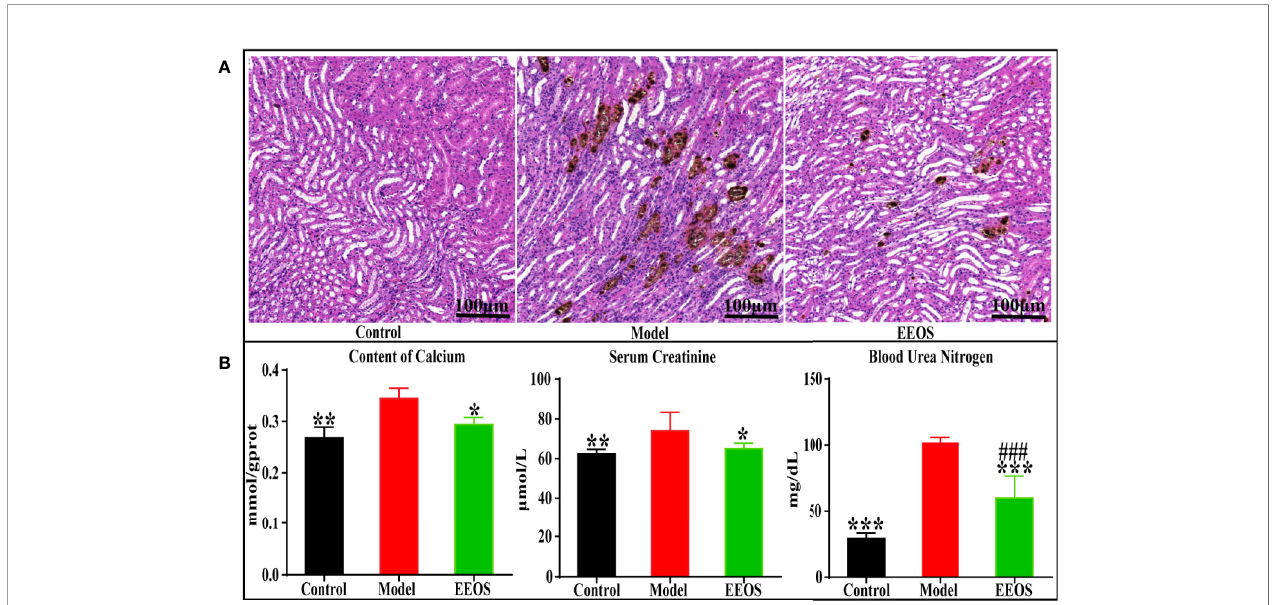
FIGURE 1 | Tissue sections (×400) and biochemical indicator analysis. (A) Kidney slice stained with Von Kossa of the control group, model group and EtOAc extract of OS (EEOS) group. A large number of calcium spots were observed in the model group kidney sections and calcium spots in kidney stones mice are signi fi cantly reduced after taking EEOS; (B) the levels of Calcium, Serum creatinine and Blood urea nitrogen in the kidneys of three groups of mice. Data are expressed as mean ± SD. ### P < 0.001 compared with the control group, * P < 0.05 compared with model group, ** P < 0.01 compared with model group, *** P < 0.001 compared with model